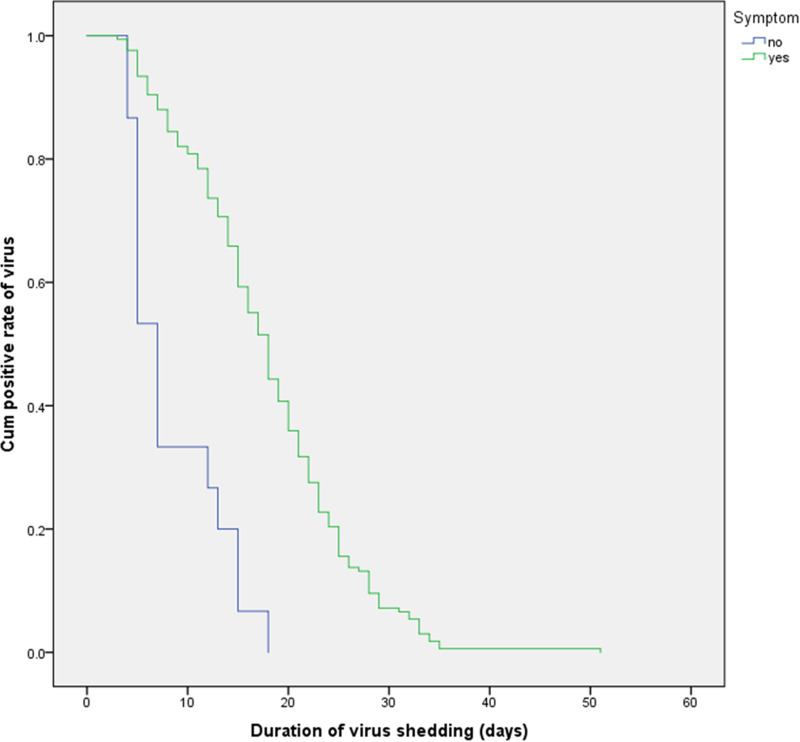
Kaplan–Meier plot for symptoms.